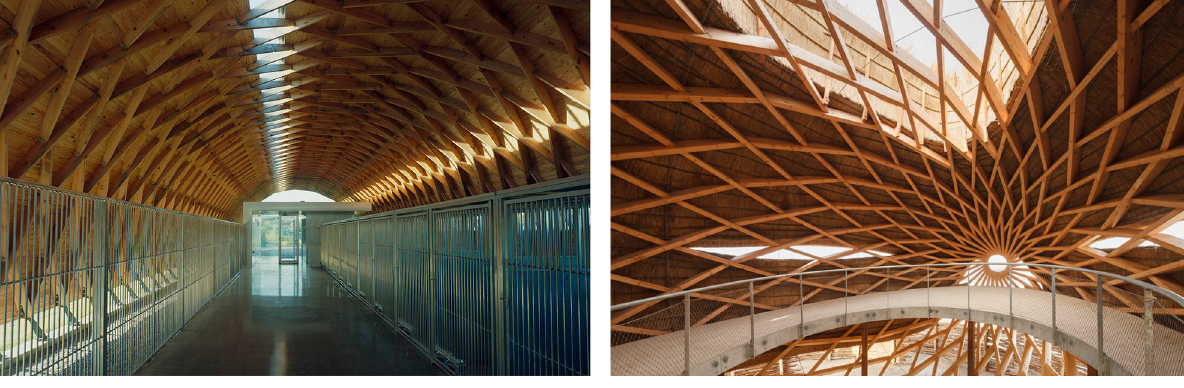
Figure 15: Left: Hale County Animal Shelter by Rural Studio (http://ruralstudio.org). Right: ”Tij” bird observatory by Geometria Architecture Ltd